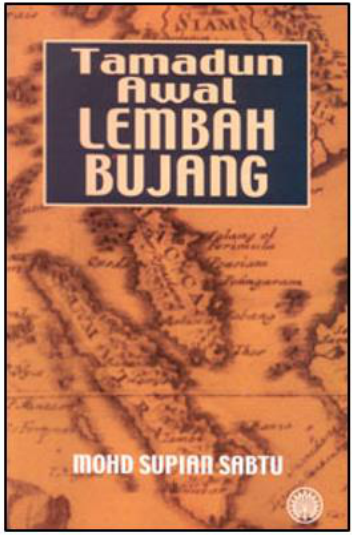
Figure 3: Book of Tamadun Awal Lembah